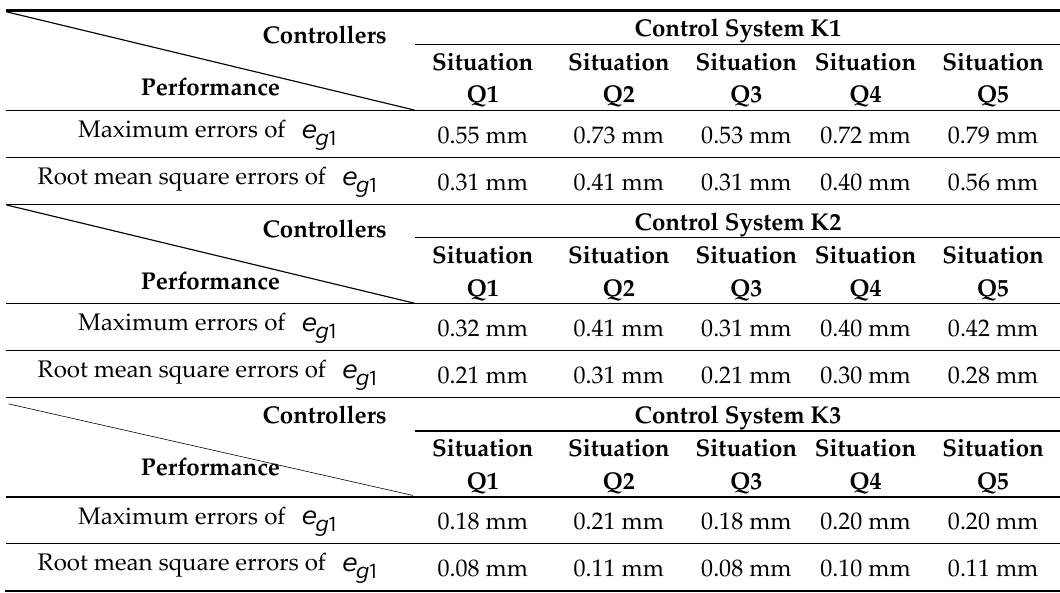
Table 1. Performance comparison of control systems.